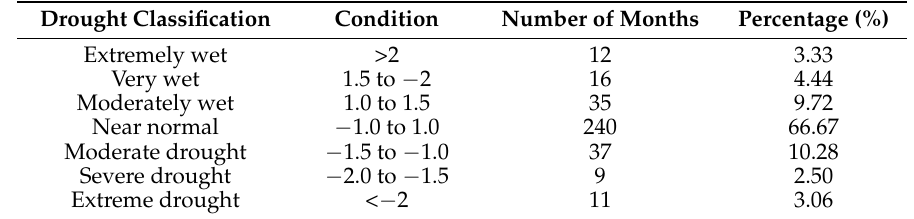
Table 7. Correlation coefficient (R) of ANN network structure (SWSI).